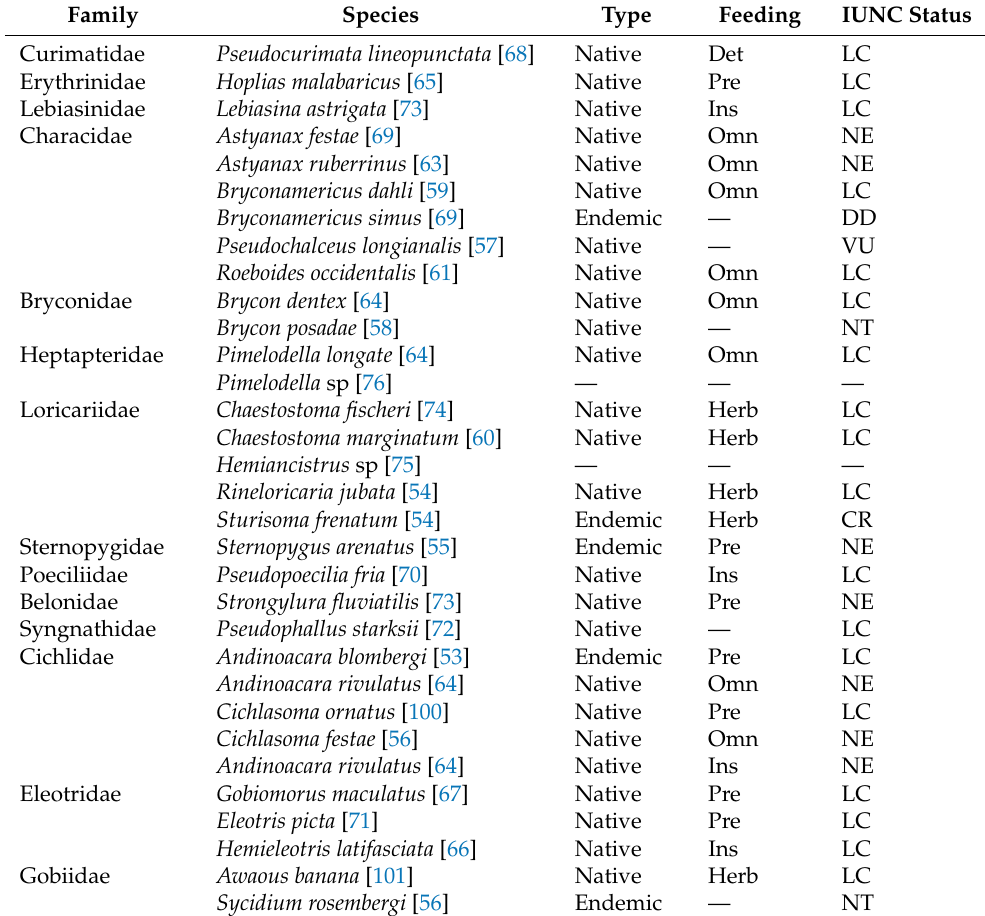
— Table A3. Taxonomical classification of the collected fish specimens (Det, detritivore; Pre, predator; Ins, insectivorous; Omn, omnivorous; Herb, herbivorous; LC, least concern; NE, not evaluated; DD, data deficient; VU, vulnerable; NT, near threatened; CR, critically